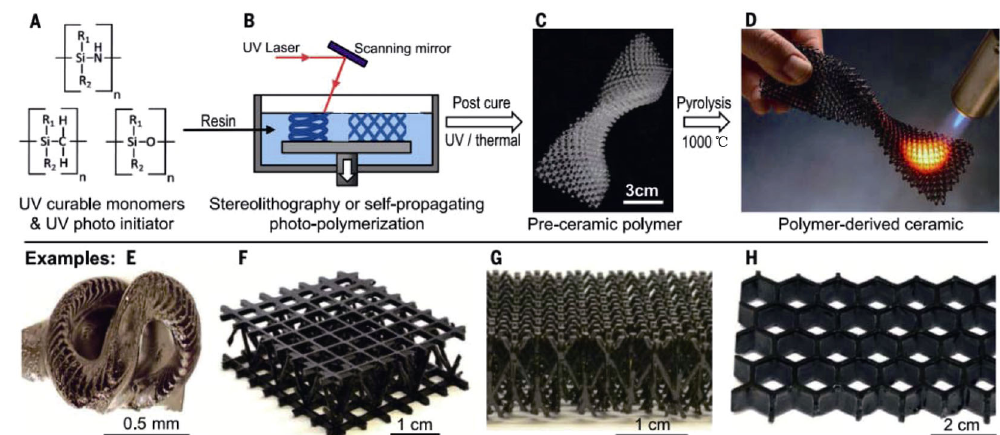
Fig. 26 SLA of polymer-derived SiOC ceramics: (A) UV-curable preceramic monomers are mixed with photoinitiator; (B) the resin is exposed with UV light in an SLA 3D printer or through a patterned mask; (C) a preceramic polymer part is obtained; (D) pyrolysis converts the polymer into a ceramic; (E–H) SLA-prepared 3D components. Reproduced with permission from Ref. [78], © American Association for the Advancement of Science 2016.